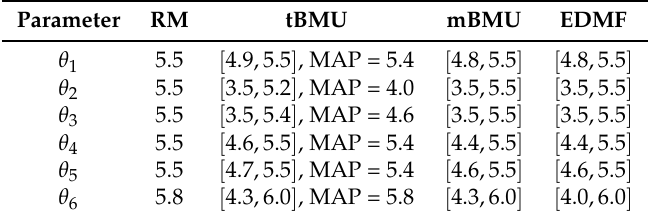
Table 10. Updated parameter ranges (posterior distributions) for Scenario 2.